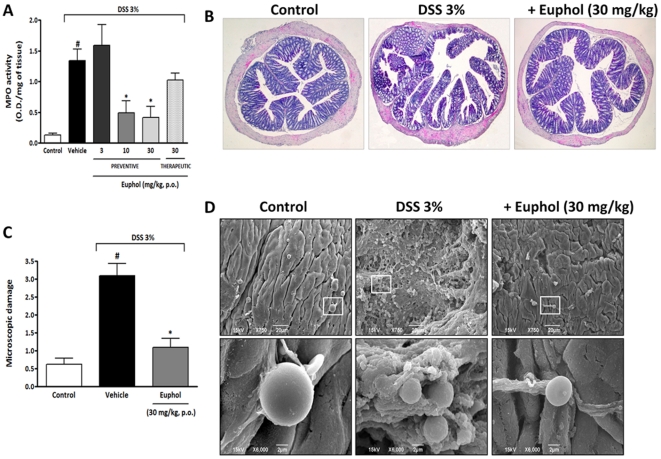
Treatment with euphol reduces cell influx and microscopic colon damage after DSS-induced acute colitis.At 7 days after euphol oral treatment, colon tissues were processed for histological evaluation, measurement of myeloperoxidase (MPO) activity and scanning electron microscopy. Preventive (3, 10, and 30 mg/kg, p.o.) or therapeutic (30 mg/kg, p.o.) treatment with euphol reduced MPO (A) activity. (B) Representative histological sections of colon from control healthy mice (non colitic), DSS-treated and euphol-treated mice (30 mg/kg, p.o.) were examined microscopically after H&E staining with original magnification x20. The images are representative of at least four mice per group. (C) Preventive treatment with euphol (30 mg/kg, p.o.) decreased the microscopic damage score in mouse colon. (D) Scanning electron microscopy photographs of the colon of the colon surfaces of control healthy mice, DSS-treated group, and DSS plus euphol (30 mg/kg, p.o.) treated mice after 7 days following DSS administration. Original magnification: x750 and x6,000, respectively. Each column represents the mean ± S.E.M. of 8 to 10 mice per group and is representative of two independent experiments. #P<0.05 vs. control healthy group (non colitic); *P<0.05 vs. DSS-treated group.